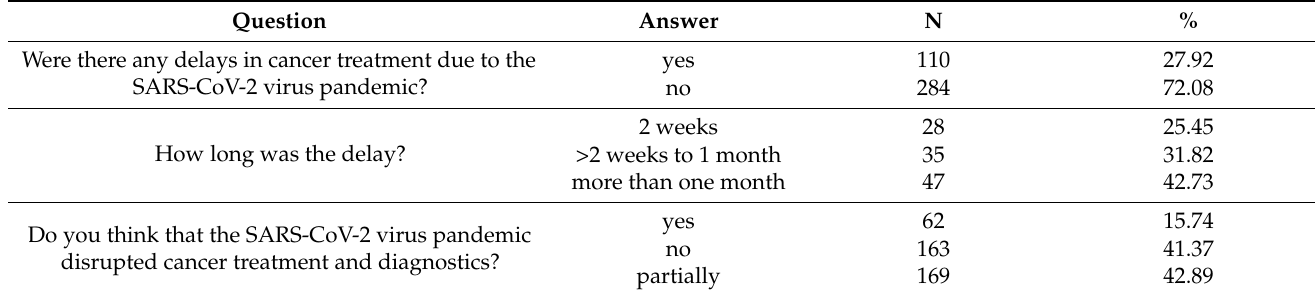
Table 3. Assessment of the impact of the pandemic on the organization of cancer treatment.